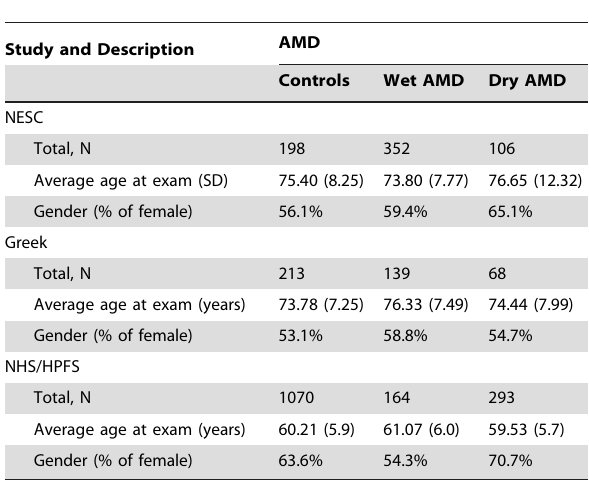
Table 1. Description of